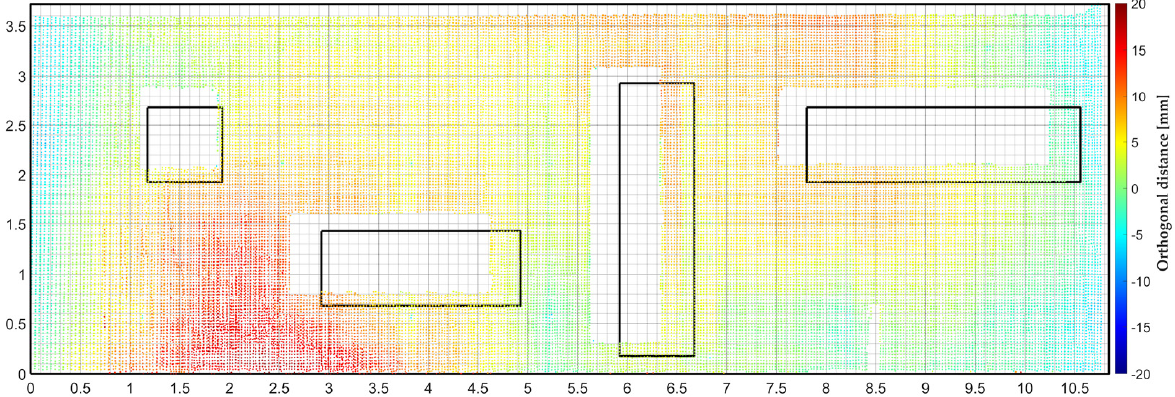
Figure 11. Comparison of the segmented as-built point cloud with the BIM model—wall no.